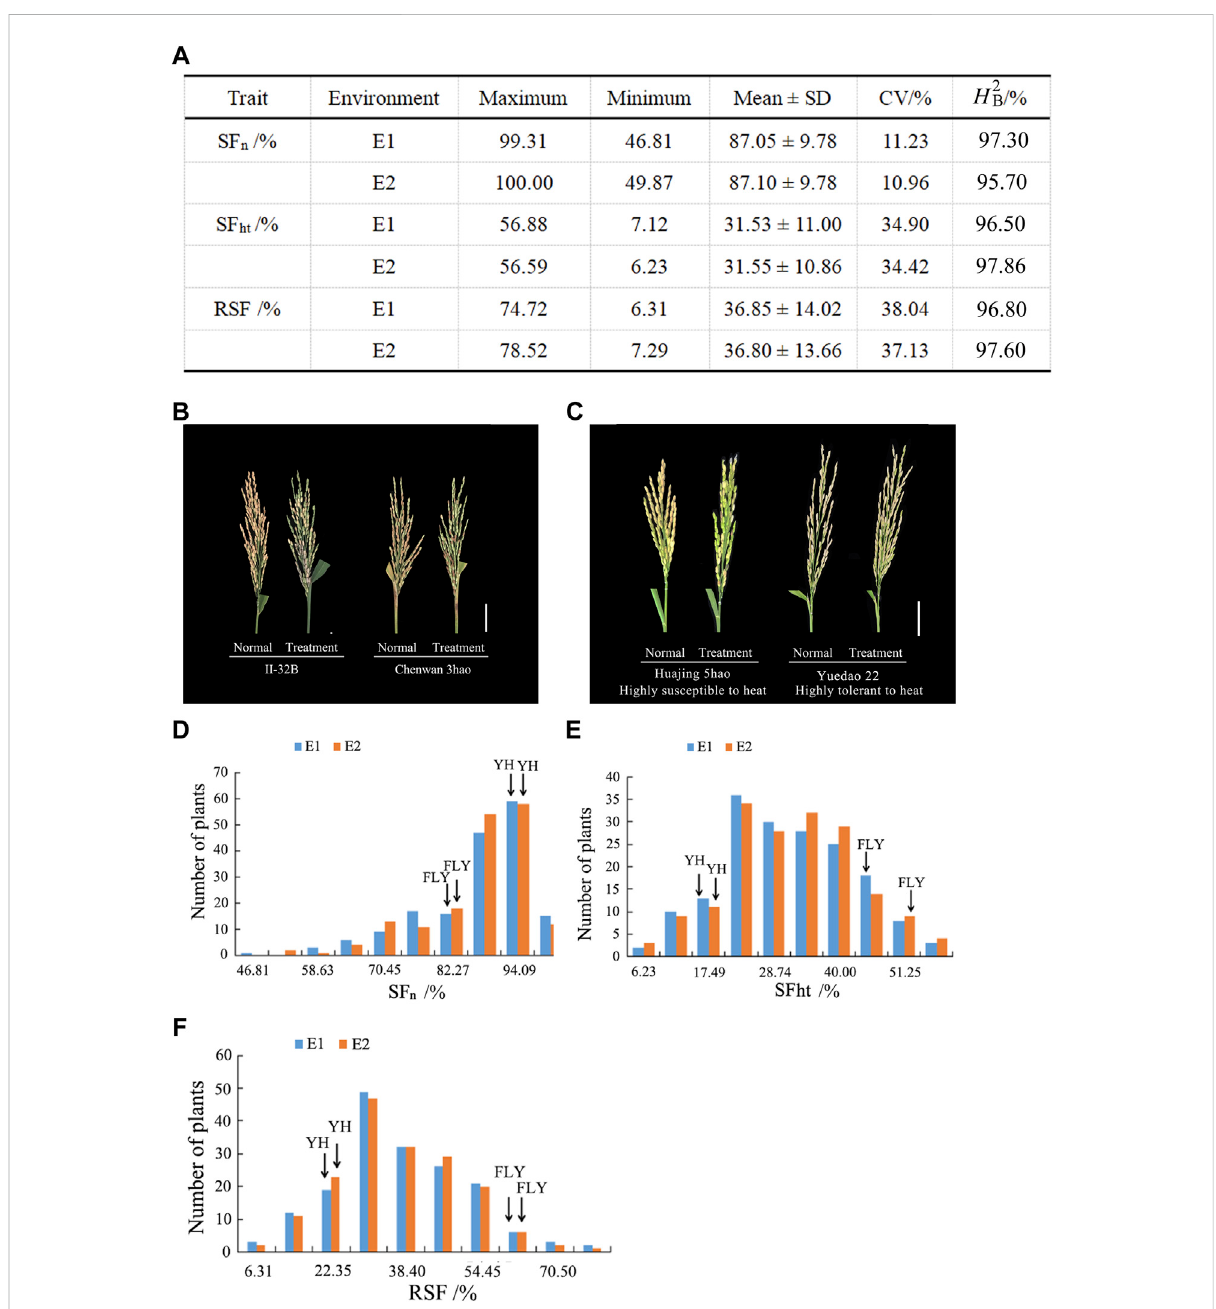
FIGURE 1 Phenotypic diversity of heat tolerance relative traits in rice. (A) Phenotypic statistics of heat tolerance relative traits in E1 and E2. (B) Panicle morphologyofmaterialsII-32BandChenwan3haointhenormal andtreatmentconditions,respectively.Scalebar, 5 cm. (C) Paniclemorphologyof material Huajing 5hao that is highly susceptible to heat and highly tolerant to heat material Shengtangqing in normal and treatment conditions, respectively. Scalebar, 5 cm. (D) Variation ofSF n amongthe173riceaccessionsinE1and E2. (E) Variation ofSF ht amongthe173riceaccessions in E1 and E2. (F) Variation of RSF among the 173 rice accessions in E1 and E2. H2 B , the broad-sense heritability; SF n , spikelet fertility in normal conditions; SF ht , spikelet fertility in high temperature conditions; RSF, relative spikelet